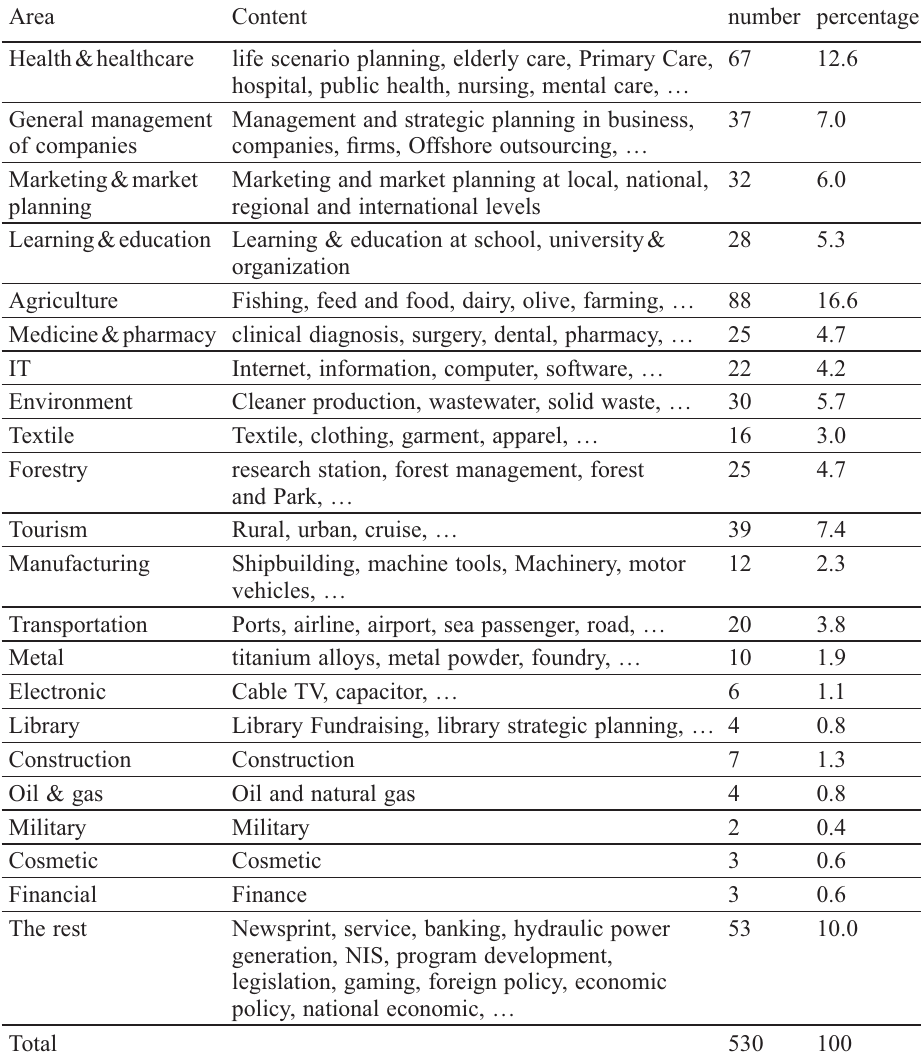
Table 7. Areas and scopes in case studies and Applied-methodological papers on